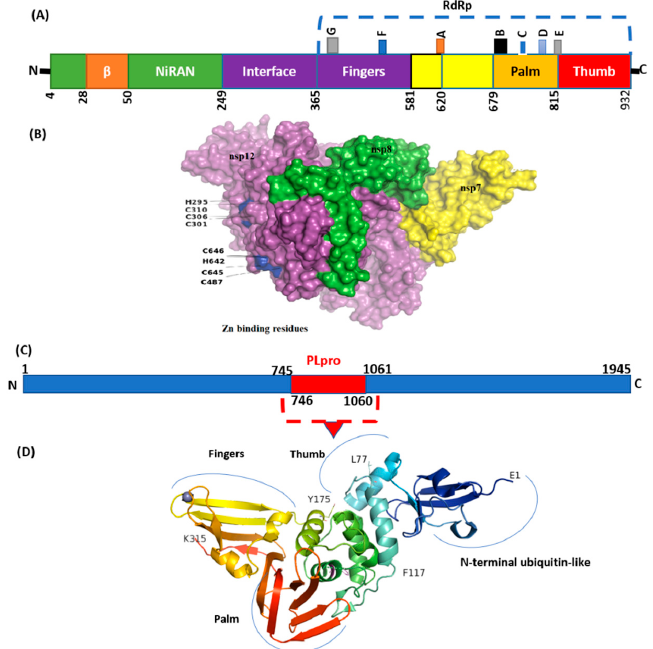
Figure 6. Structure of NSP12 and NSp3 (PLpro). ( A ) SARS-CoV-2 RdRp (PDB ID: 6M71) contains an